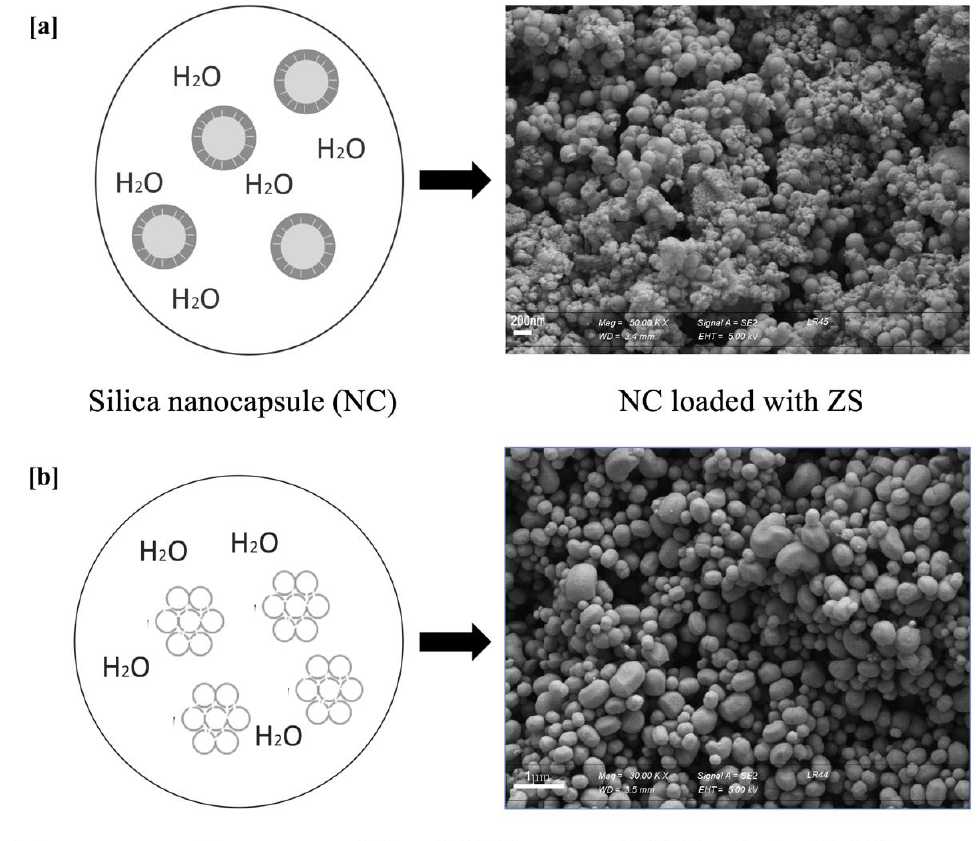
Figure 1. Structure of nanocontainers synthetized: ( a ) Silica Nanocapsule (NC): Scheme, SEM images of NC loaded with Zostera sodium salt (ZS); ( b ) Mesoporous silica nanoparticles (MNP): Scheme, SEM images of NC loaded with Zostera sodium salt (ZS). For the representation of Silica Nanocapsule and Mesoporous silica nanoparticles loaded with MBT, we refer to Ruggiero et al. [21]. A micellar solution was obtained by combining water, surfactant, and the basic